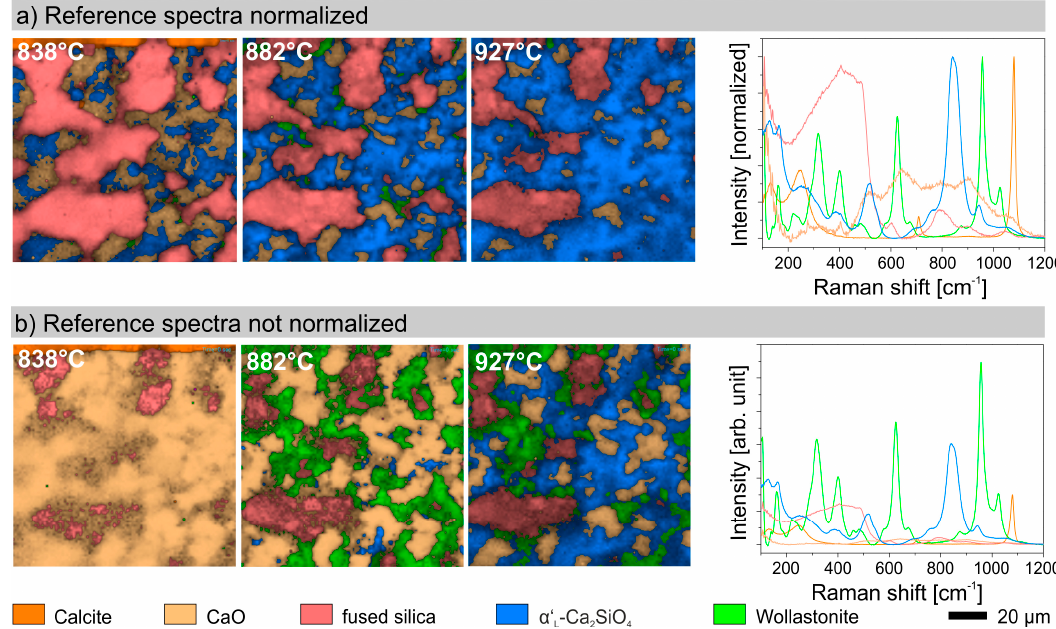
Figure 8. A series of three hyperspectral Raman images taken between 838 °C and 927 °C which are generated with the classical least-squares (CLS) fitting method using in-house reference spectra that are ( a ) normalized and ( b ) not normalized before loading. The reference spectra in (b) are recorded at the same measurement setup and thereby the Raman cross-sections of the individual mineral phases are considered. Note that the normalization of the reference spectra causes mineral phases with low Raman scattering cross-sections such as CaO to be underrepresented in the image.